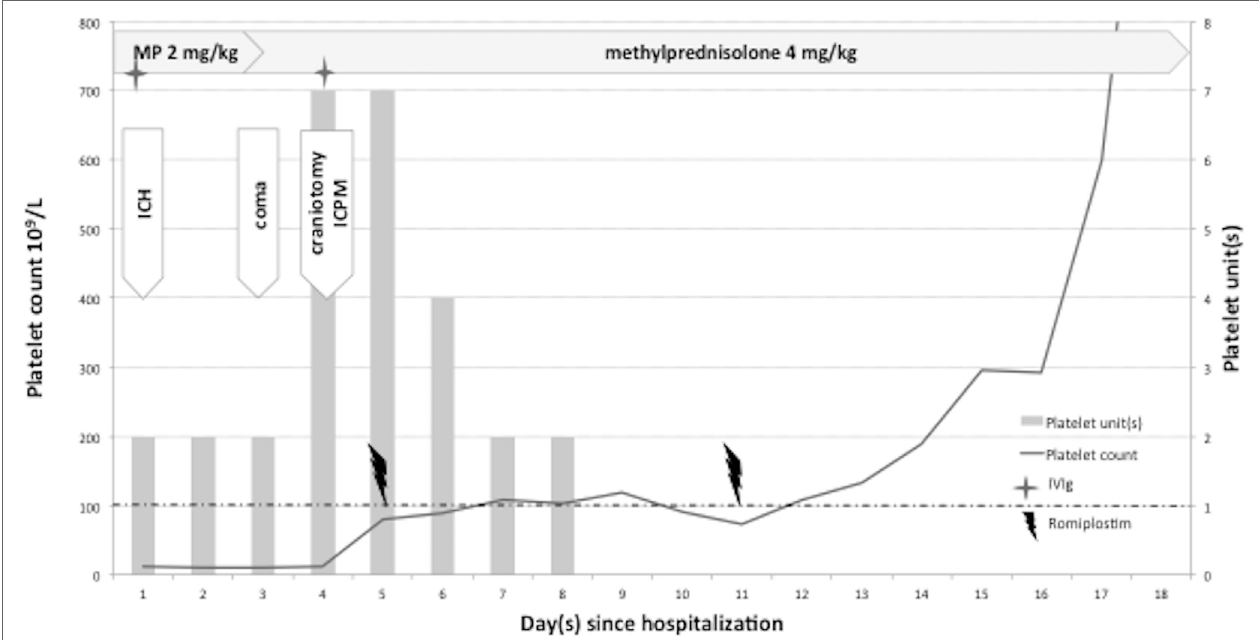
FIgURe 3 | Patient 2. Platelet counts and platelet transfusions during intensive care hospitalization. Combined therapy including romiplostim as emergency management for severe ITP complicated by intracranial hemorrhage (ICH). ICPM = intracranial pressure monitoring (intraparenchymal